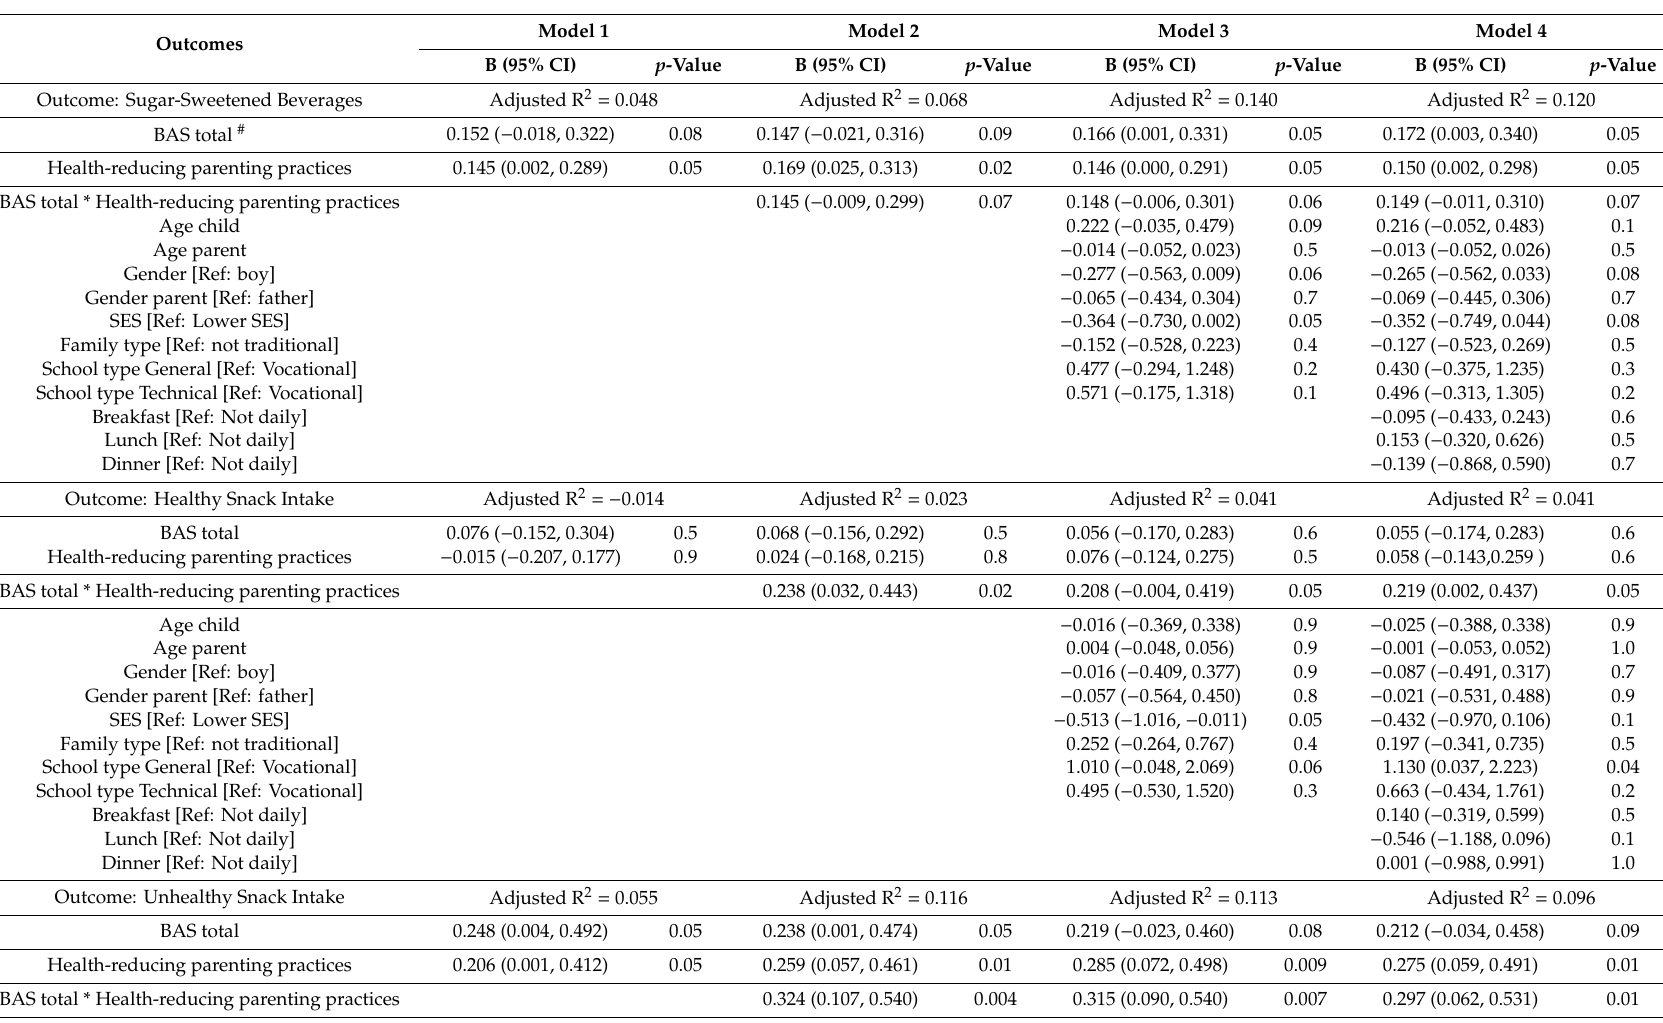
Table A6. Associations between reward sensitivity and adolescents’ intake of sugar-sweetened beverages, healthy and unhealthy snacks, and the moderating role of (parent-reported) health-reducing parenting